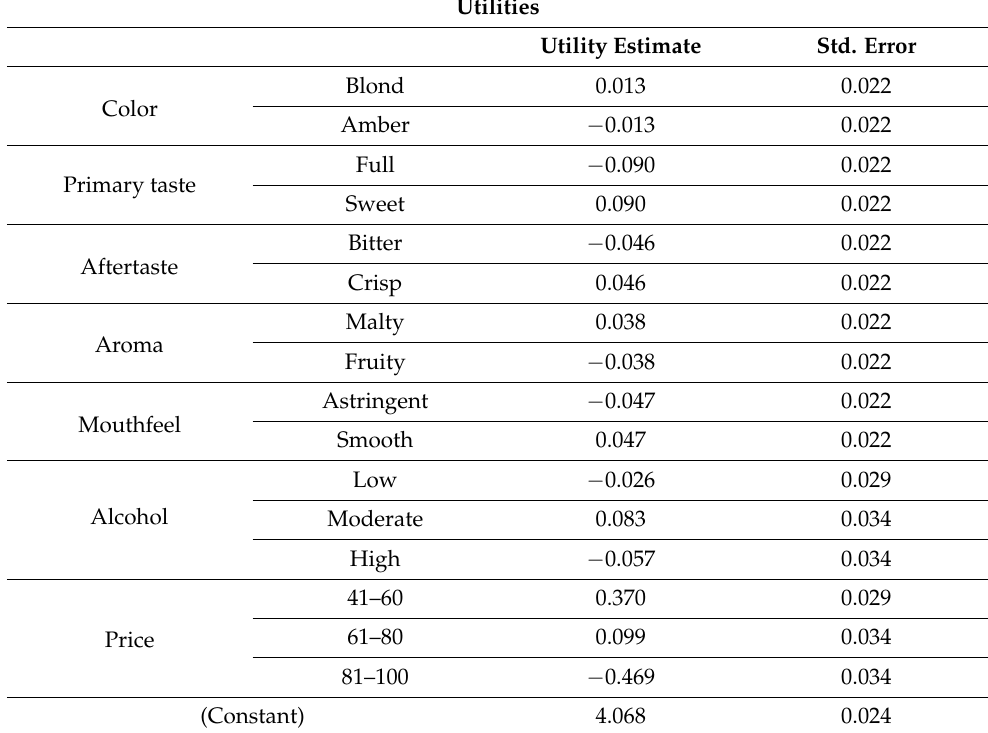
Table 8. Summary of utilities.